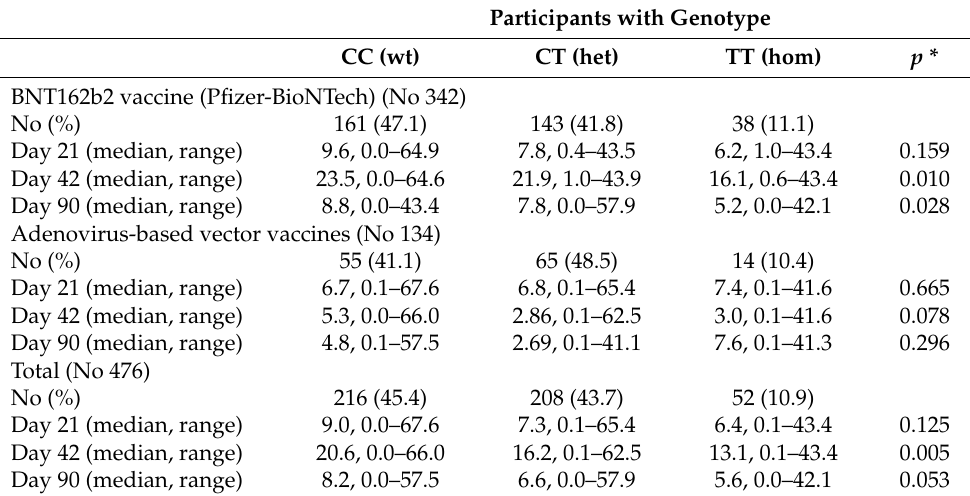
Table 1. Association of rs1883832 polymorphism with IgA responses (U/mL) after COVID-19